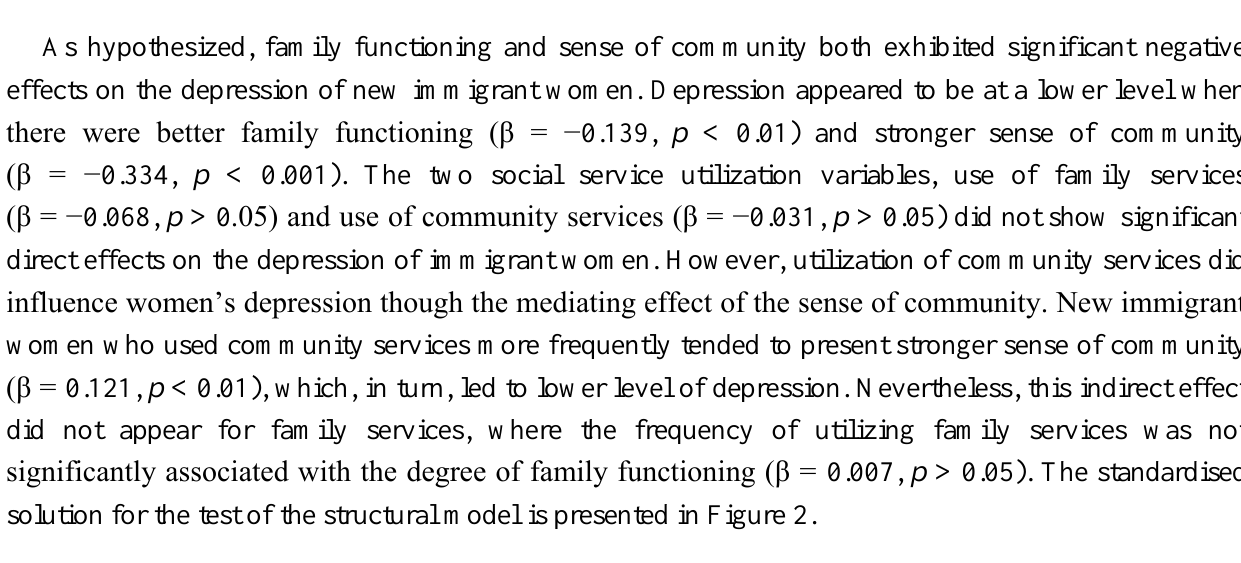
Figure 2. Standardized solutions for the structural model of social service utilization, family functioning, sense of community and